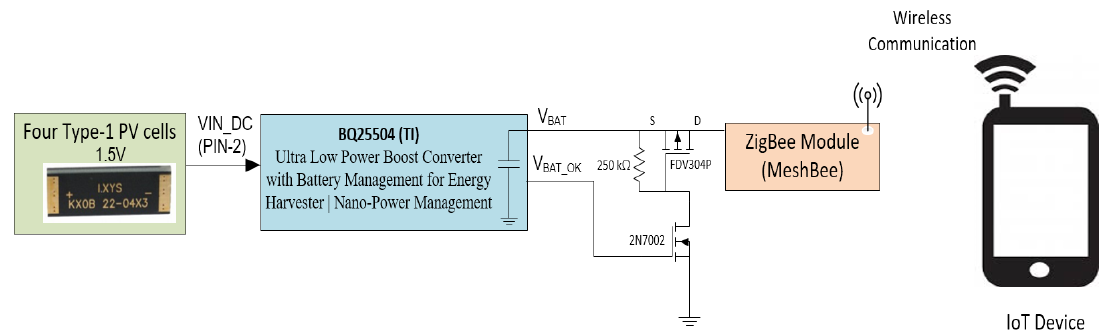
Figure 9. The testing scheme for powering the load during ZigBee communication, using light energy harvesting.